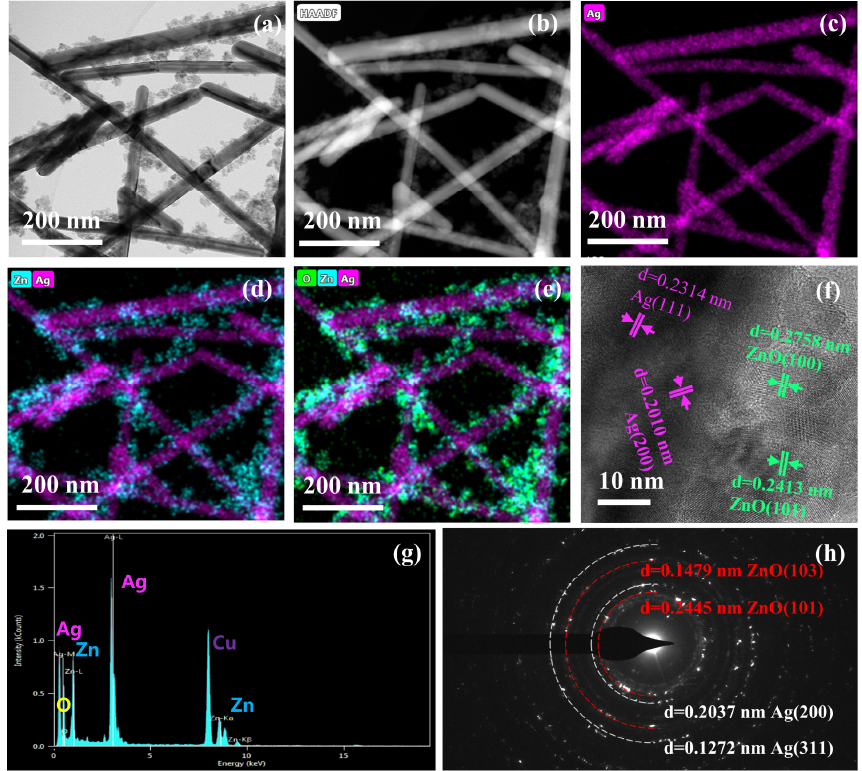
Figure 1. Characterization of ZnO NPs@Ag NWs (0.02 g) by transmission electron microscopy. TEM ( a ), HAADF-STEM ( b ), EDS mapping images ( c – e ), HRTEM ( f ), EDS spectrum ( g ), and SAED pattern ( h ) of ZnO NPs@Ag NWs (0.02 g).